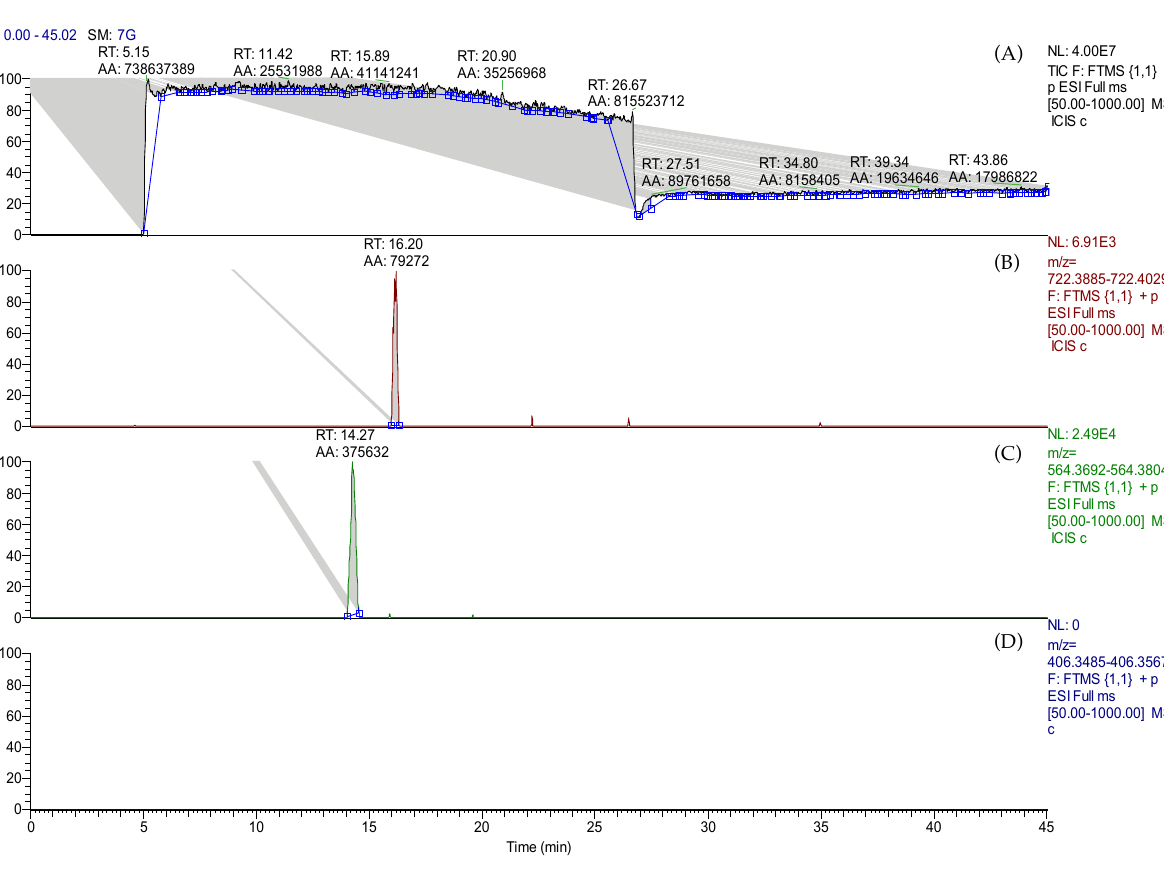
Figure 2. LC-HRMS results. (A) Total Ion Current (TIC) and extracted ion chromatograms (XIC); (B) filtered on the accurate mass of fumonisin B 1 ; (C) partially hydrolyzed form of FB 1 (PHFB 1 ); and (D) hydrolysed fumonisin B 1 (HFB 1 ) in control solutions without Pleurotus